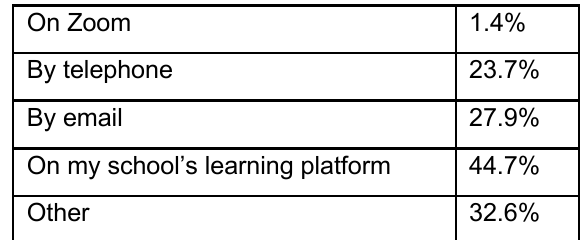
Table 5: 3rd-year students’ answers to the question, ‘What media/platforms were used for the supervision?’ (you may select more than one)